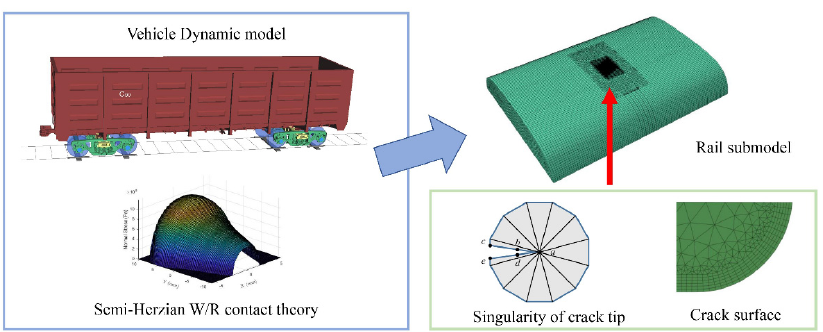
Figure 6. General description of construction process of crack analysis model.